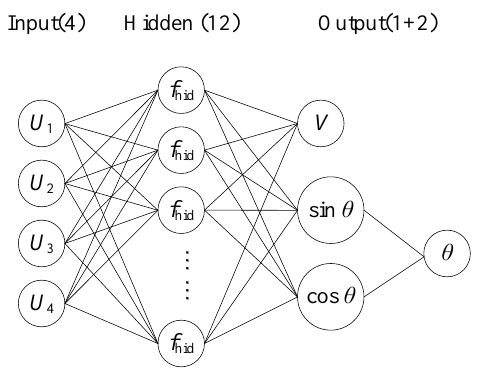
Figure 8. Improved network structure with sine and cosine as